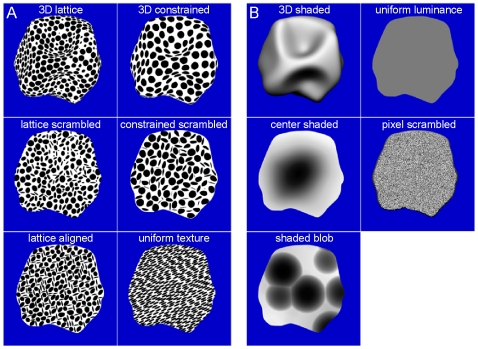
Visual stimuli.(A) Texture stimuli, from top to bottom, left column: 3D lattice, lattice scrambled, and lattice aligned; right column: 3D constrained, constrained scrambled and uniform texture. (B) Shading stimuli, from top to bottom, left column: 3D shaded, center shaded, shaded blob; right column: uniform luminance, and pixel scrambled.